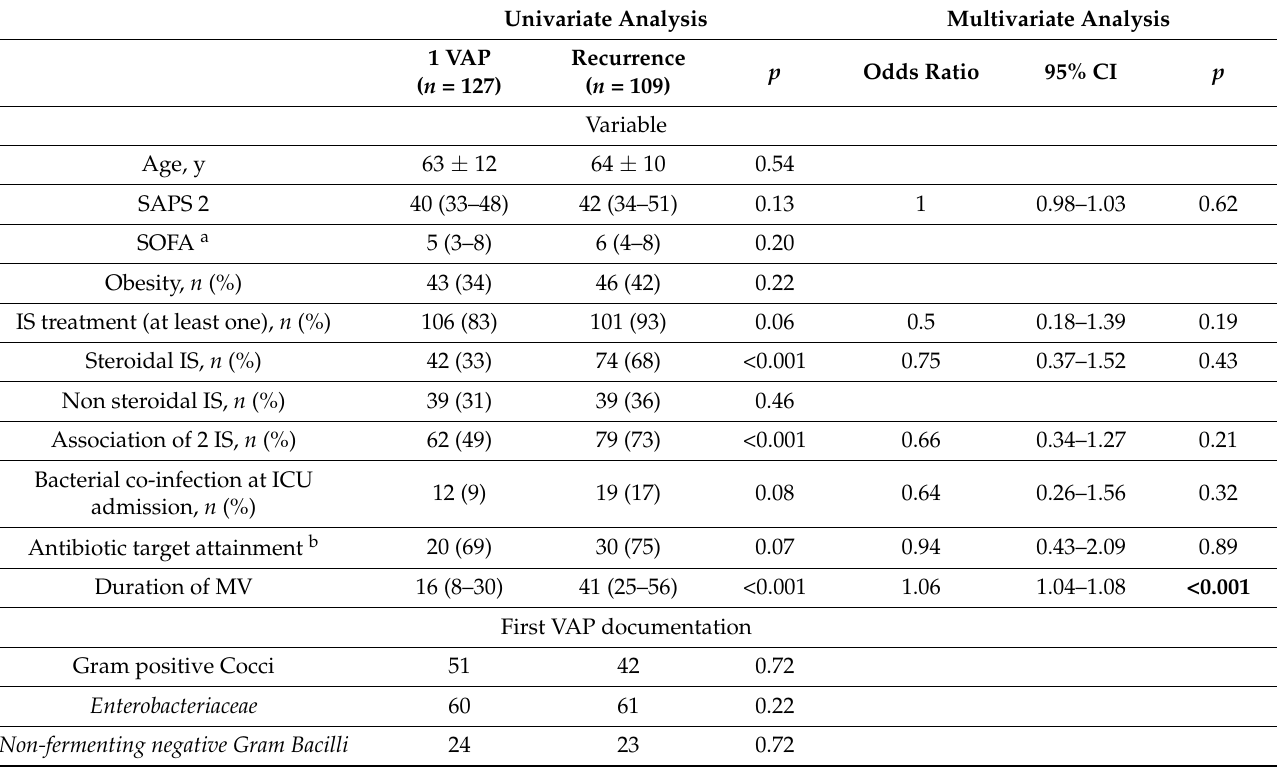
Table 5. Factors associated with VAP recurrence in univariate and multivariate analysis.